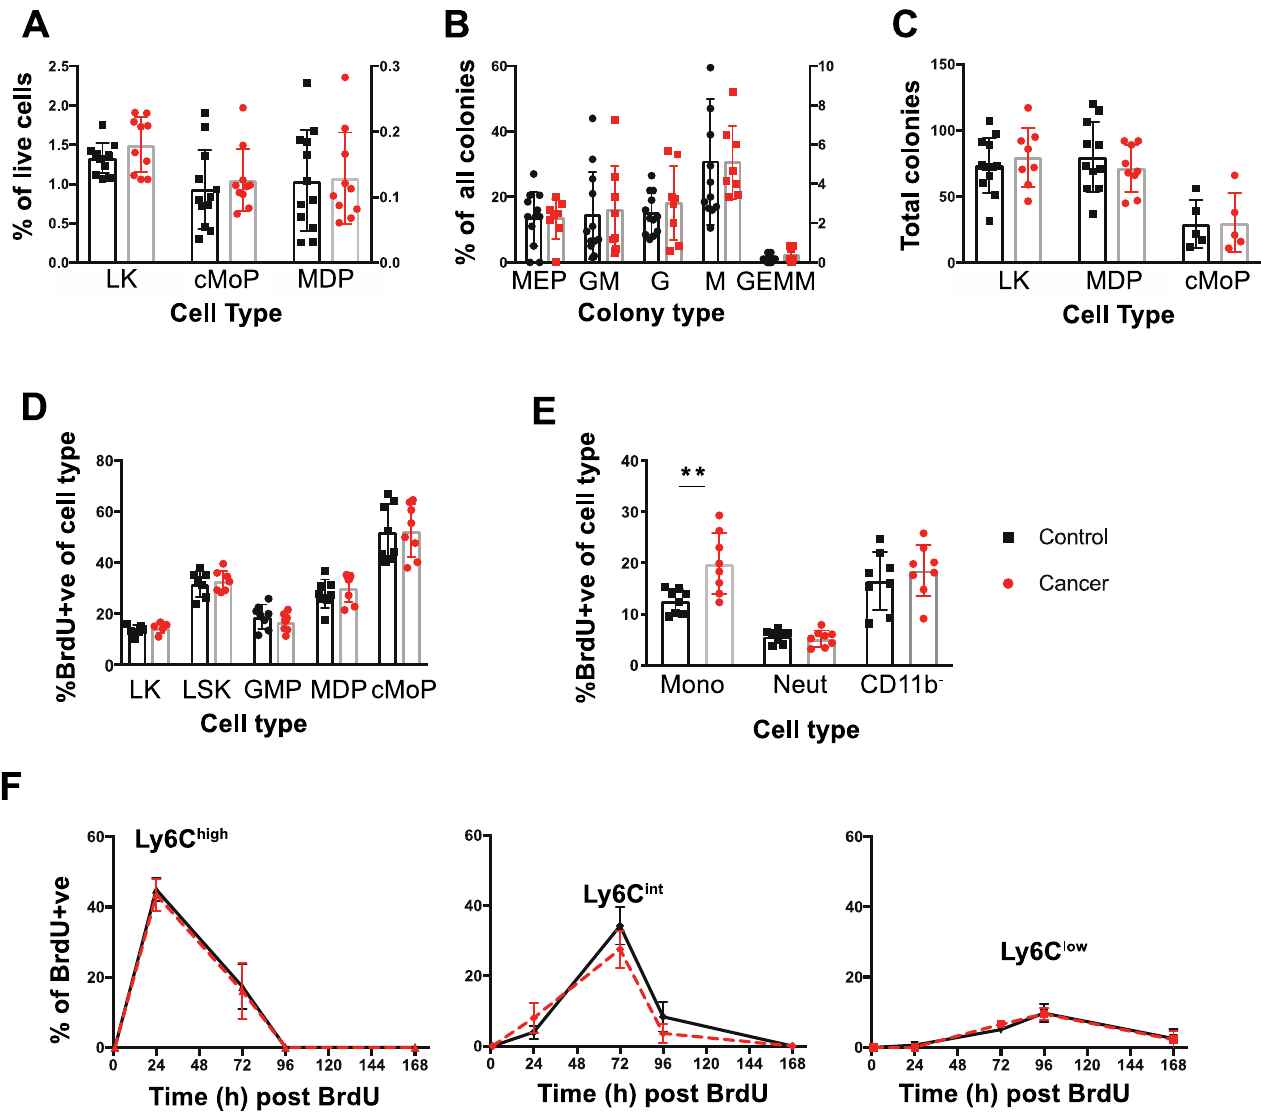
Figure 2. Dynamics of monopoiesis in tumor bearing mice. ( A ) Proportion of LK, cMoP, and MDP cells within the BM shown as a percentage (%) of total live cells extracted from the bone marrow. ( B ) Distribution of colony types within the LK CFU methylcellulose assays expressed as a % of each colony type from the total colony number. ( C ) Isolated LK cells, MDPs, and cMoPs progenitors were cultured in CFU assays in methocellulose for 12–14 days and the total number of colonies present